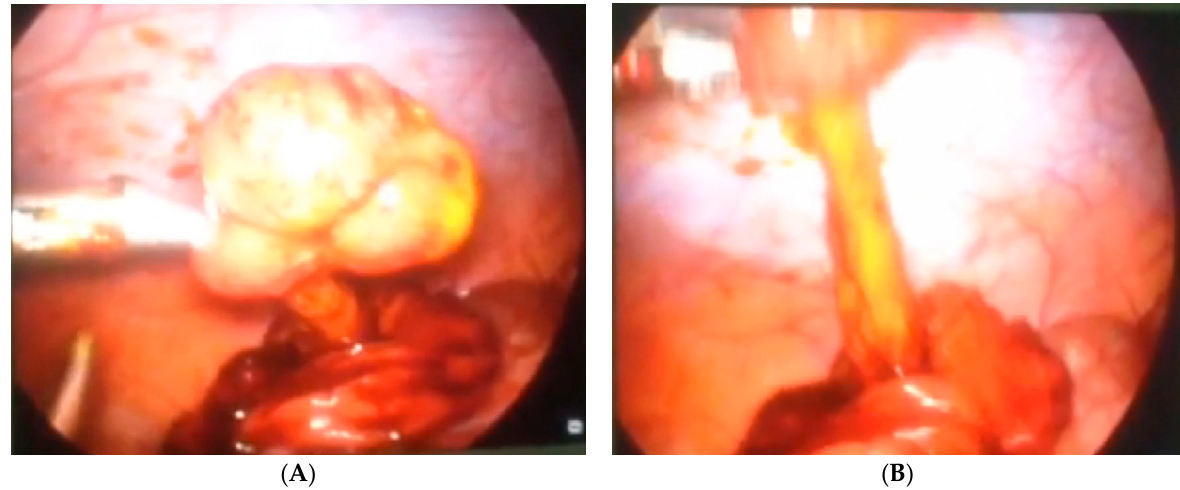
Figure 6. ( A ) Laparoscopic excision of the cecum polyp, ( B ) polyp on the long loop.